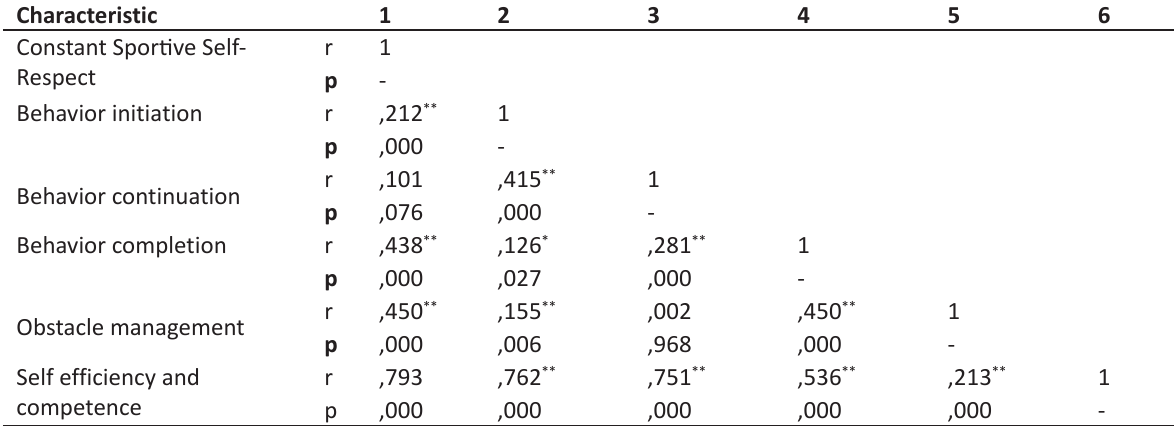
Table 3. Relationship between Self efficiency Competence Levels and Constant Sportive self-respect Levels Characteristic